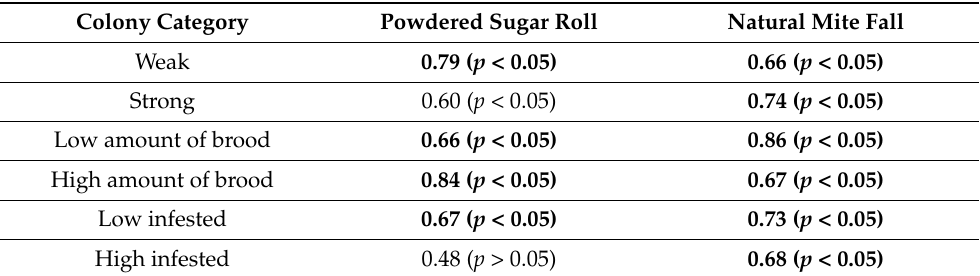
Table 3. Spearman correlation between colonies classified according to strength, amount of brood and infestation class, and dispersal infestation level obtained using different methods. Protocol 1. Only Croatian apiaries were